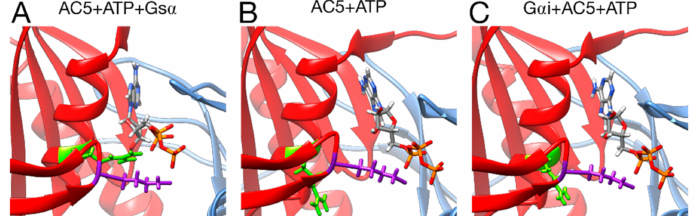
Figure 8. Interactions between ATP and key residues in di ff erent complexes. ( A ) active AC5 + ATP + Gs α , ( B ) inactive AC5 + ATP complex, ( C) inactive G α i_tilted + AC5 + ATP complex. Key residues of C2 are shown as sticks and colored in purple (LYS 1065) and green (ARG 1029). The C1 and C2 subunits of AC5 are colored blue and red, respectively. For clarity, the region 394–428 of C1 is omitted from the